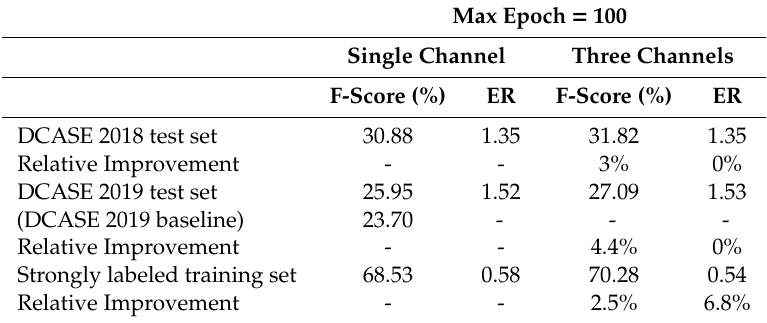
Table 5. SED results of the mean-teacher model using derivative features (max epoch = 100).